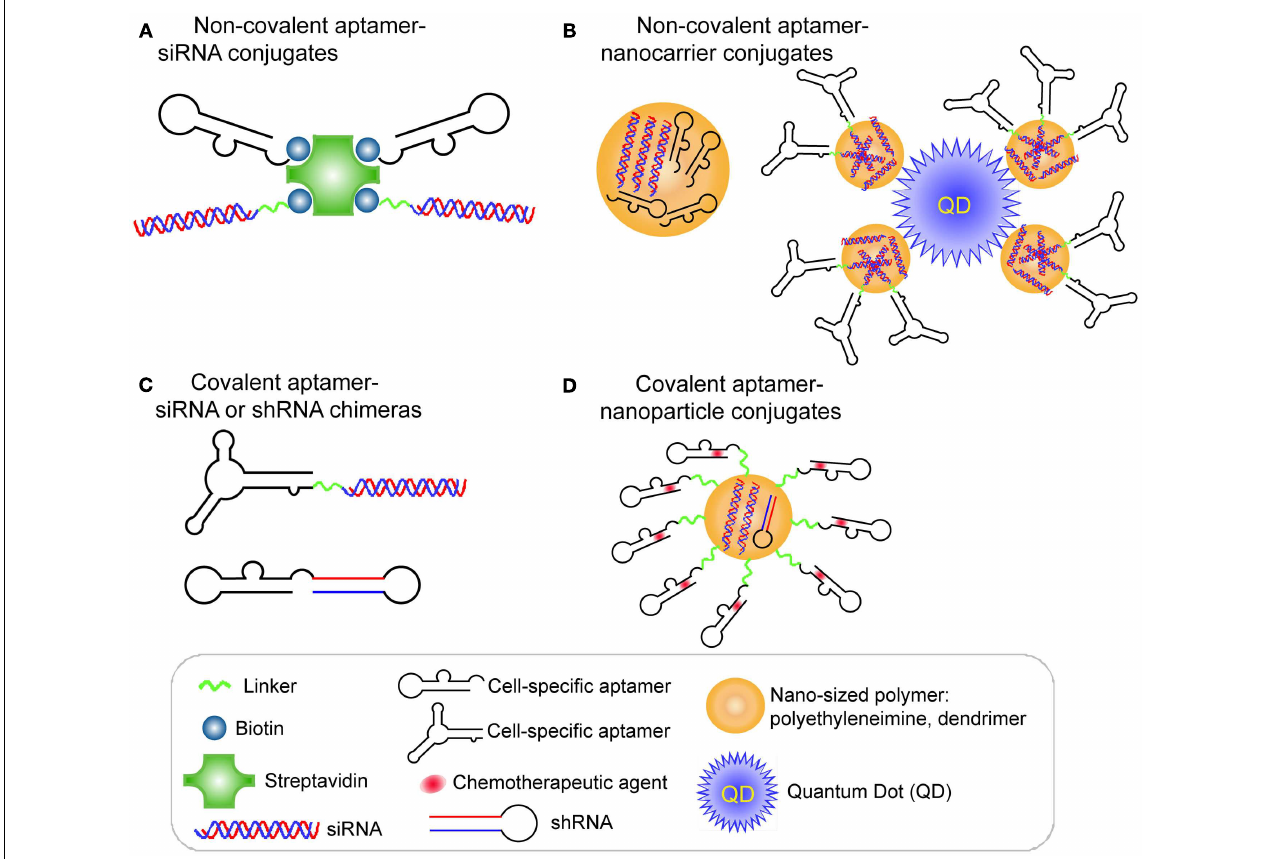
FIGURE 2 | RNA aptamer-mediated targeted RNAi delivery in cancer therapy. (A) Schematic of non-covalent aptamer-siRNA conjugates. Cell-specific aptamers and 27-mer Dicer substrate siRNA duplexes were chemically conjugated with a biotin group.Thus, two biotinylated DsiRNAs and two aptamers were non-covalently assembled via a Streptavidin platform. (B) Schematic of covalent aptamer-siRNA or shRNA chimeras. The 2 (cid:48) -Fluoro modified aptamer and siRNA sense strand were co-transcribed, followed by annealing of the complementary siRNA antisense strand to complete the chimeric molecule. Or the aptamer and shRNA strand were co-transcribed to obtain the 2 (cid:48) -Fluoro modified chimeric RNA. (C) Schematic of non-covalent